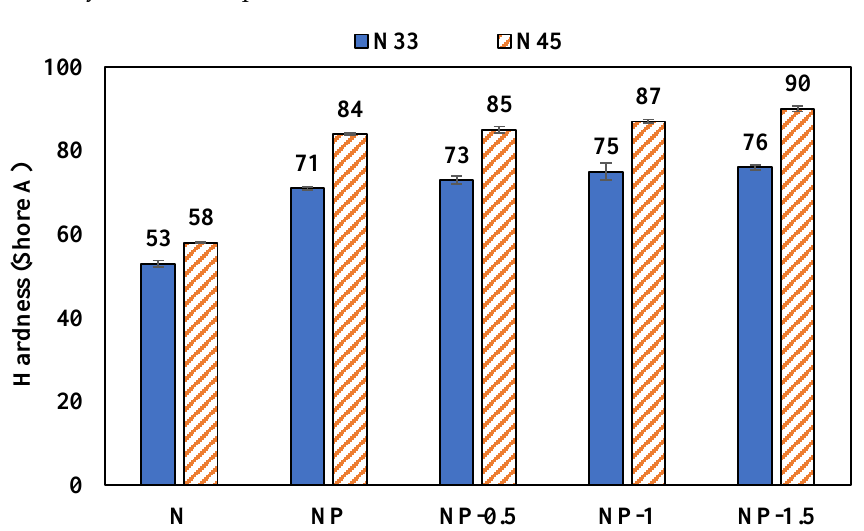
Figure 7. Hardness results of the samples.